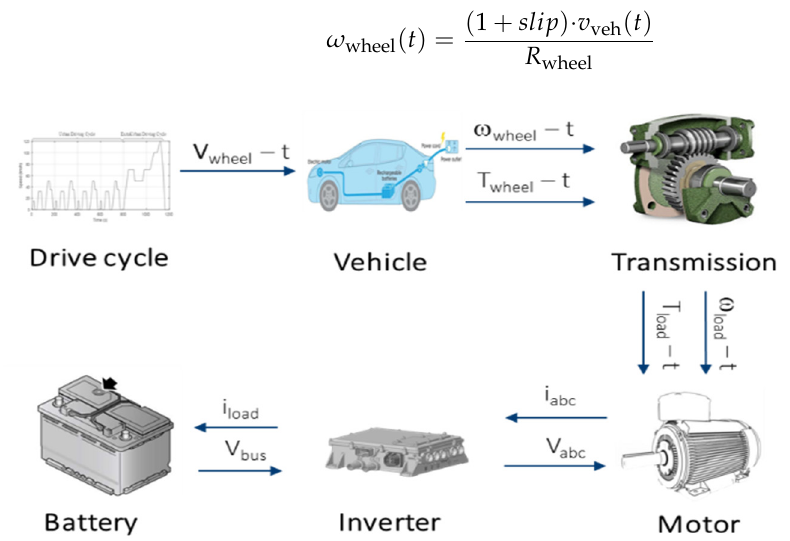
Figure 5. Calculation flow of the vehicle-level modeling.